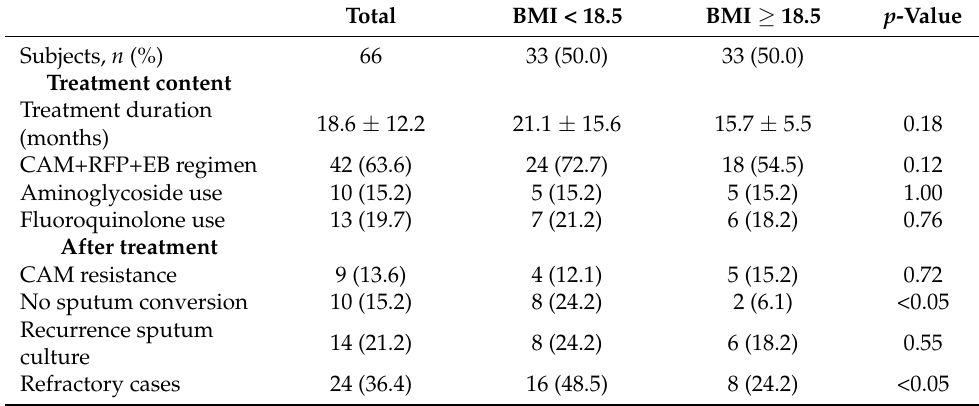
Table 4. Treatment regimens and outcomes of the MAC-PD patients with a BMI < 18.5 kg/m 2